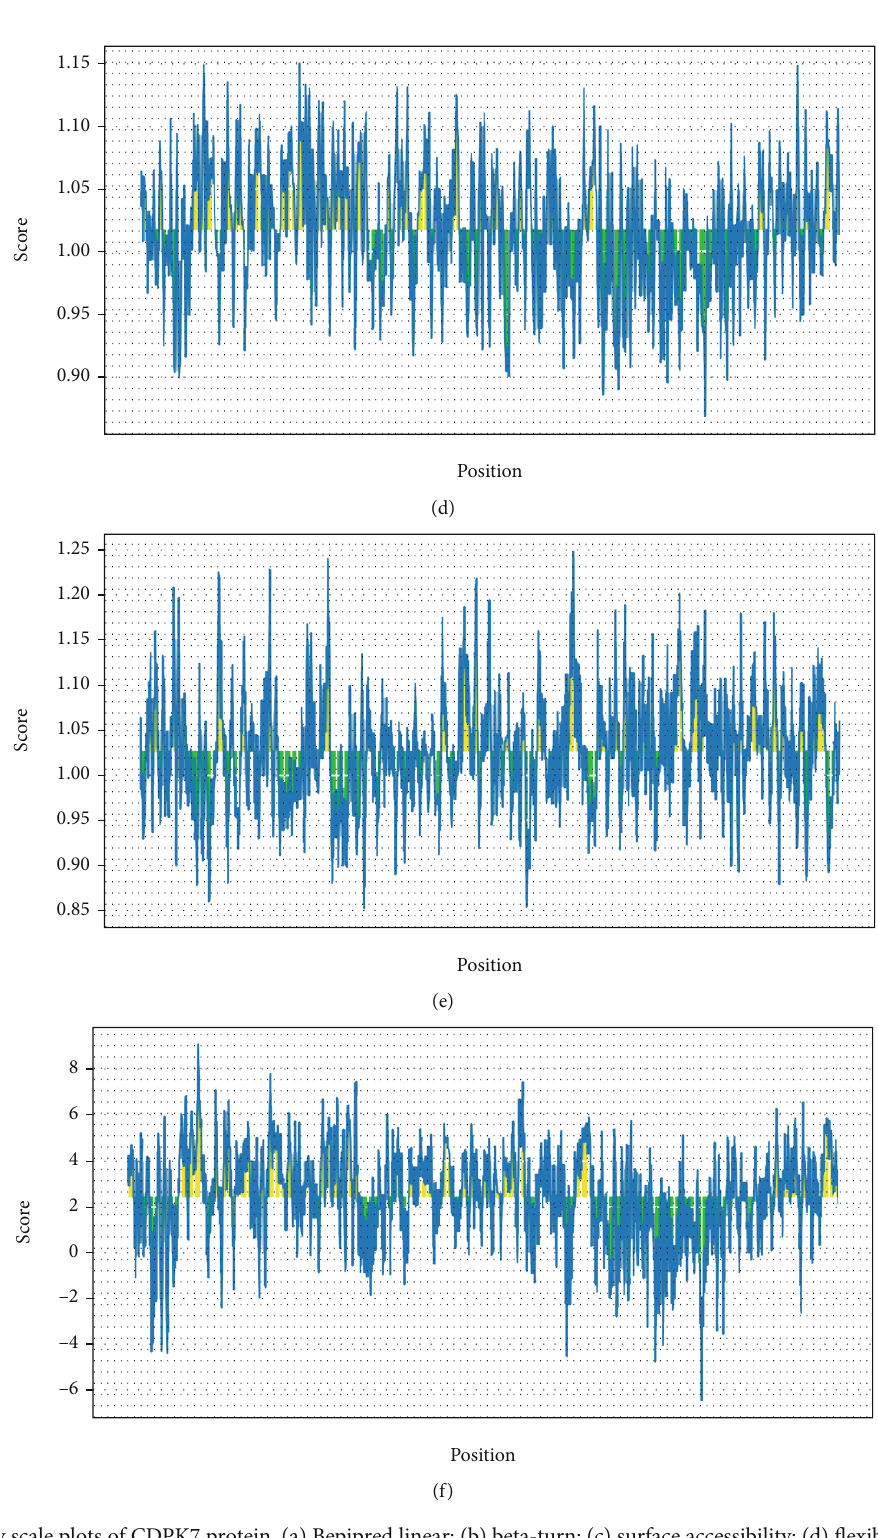
Figure 6: Propensity scale plots of CDPK7 protein. (a) Bepipred linear; (b) beta-turn; (c) surface accessibility; (d) fl exibility; (e) antigenicity; (f) hydrophilicity. x -axis and y -axis represent position and score, respectively. The horizontal line indicates the threshold or the average score. Yellow colors (above the threshold) indicate favorable regions related to the properties of interest. Green color (below the threshold) indicates the unfavorable regions related to the properties of